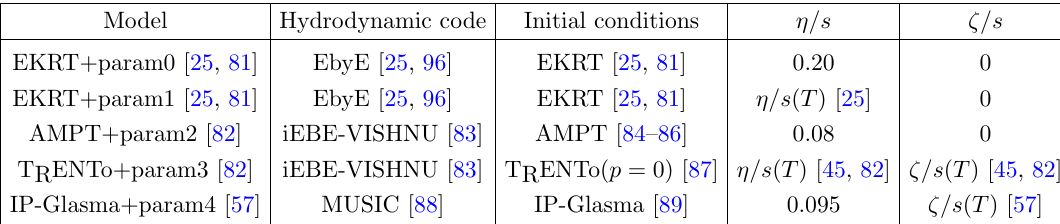
Table 5 . Hydrodynamic model con(cid:12)gurations. Shown are the key components such as initial condition models, and (cid:17)=s and (cid:16)=s parameterizations. With TRENTo initial conditions, an entropy deposition parameter p = 0 [82] is used for all